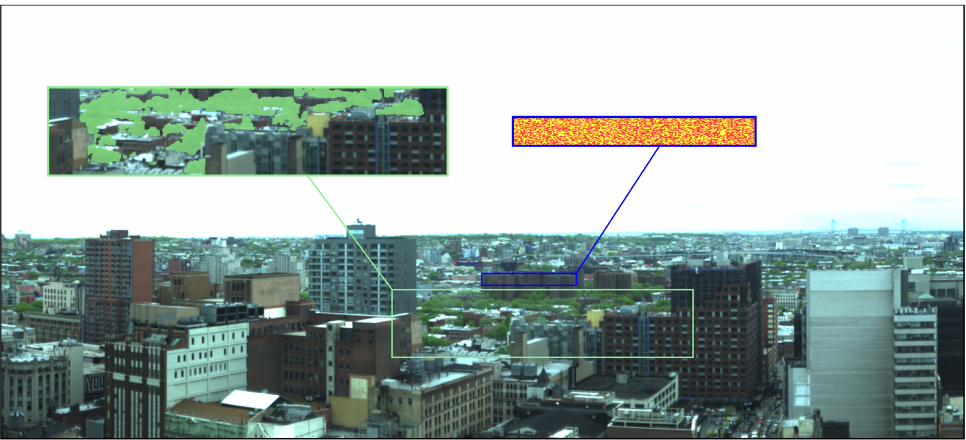
Figure 1. Full-resolution RGB (0.61 µ m, 0.54 µ m, and 0.48 µ m) representation of the scene of Downtown and North Brooklyn imaged by the Urban Observatory’s hyperspectral imaging system. The blue box shows the buildings used as controls, which were randomly split into two equal sets, represented by the red and yellow pixels in the expanded view. The green box shows the vegetation pixels (identified using k -means clustering and highlighted in the expanded view in green) whose spectra are used in this